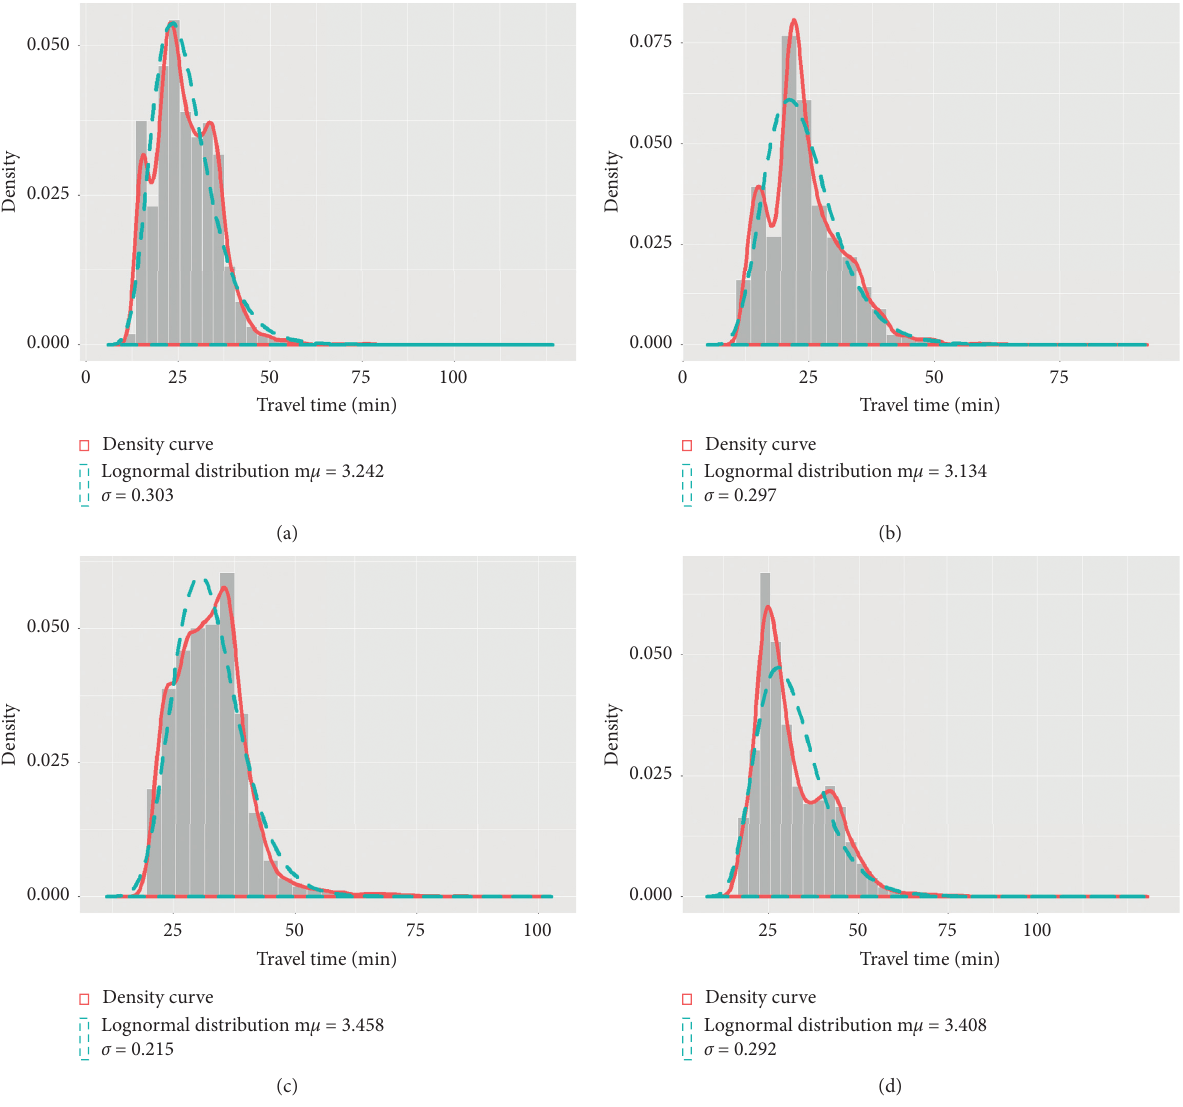
Figure 3: Selected distributions for the observed travel time data of four routes. (a) Yanan elevated expressway Eastbound, (b) Yanan elevated expressway Westbound. (c) Yanan arterial road Eastbound, and (d) Yanan arterial road